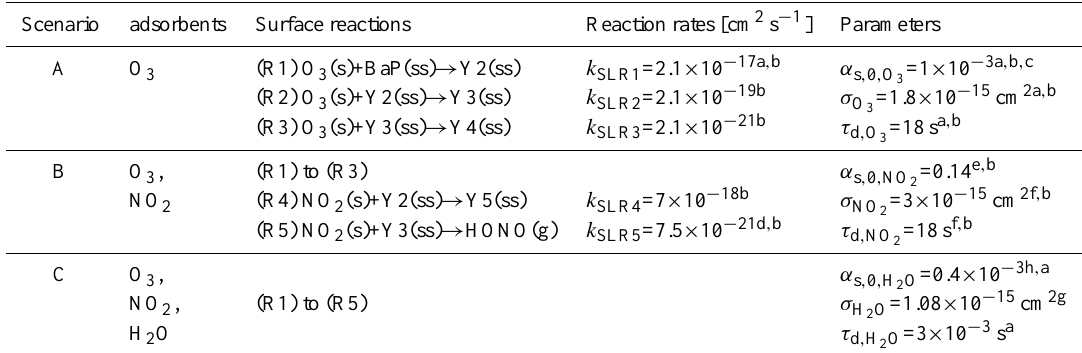
Table 1. Adsorbents, surface reactions, reaction rates, and parameters – accommodation coefficient ( α ), effective molecular cross section ( σ ), desorption time ( τ ) – applied in model scenarios A, B, C.